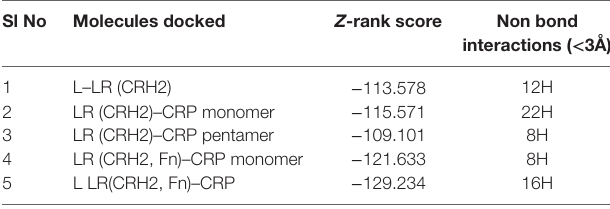
TaBle 1 | Docking scores and H-bonding interactions of CRP and